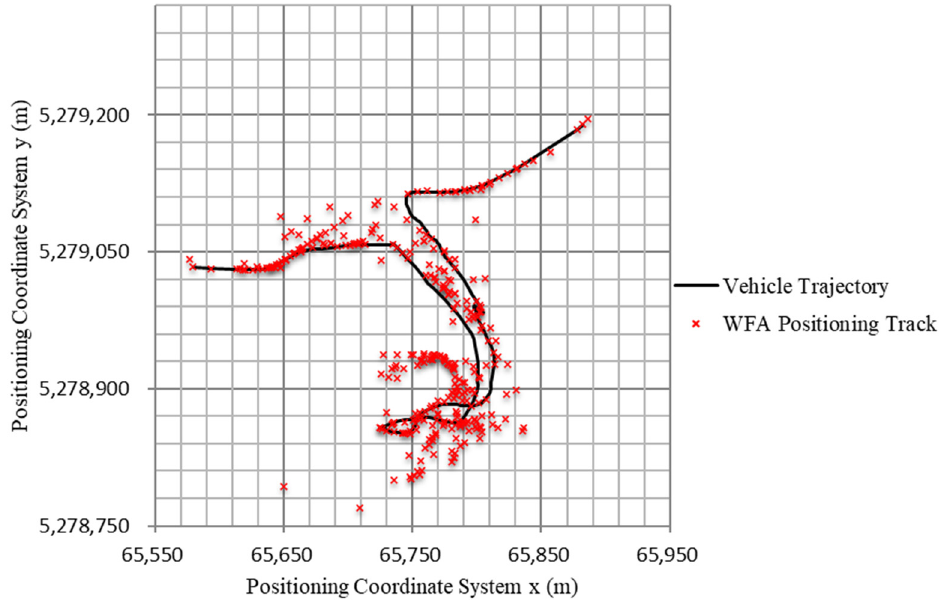
Figure 4. WFA fusion method trajectory.